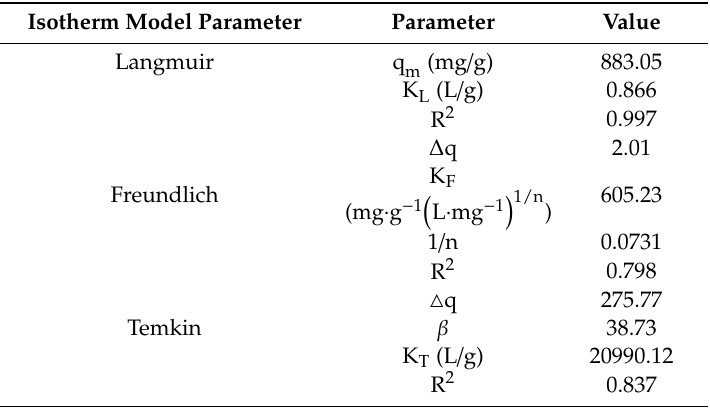
Table 3. The parameters of di ff erent isotherms